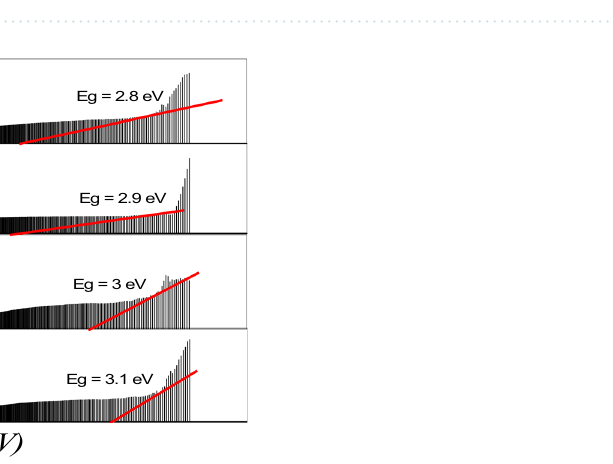
Figure 6. Representative of the UV–vis–IR reflectance spectra of Cu–TiO 2 with different weight percentages of 20, 30, and 40 wt.% of TiO 2 .